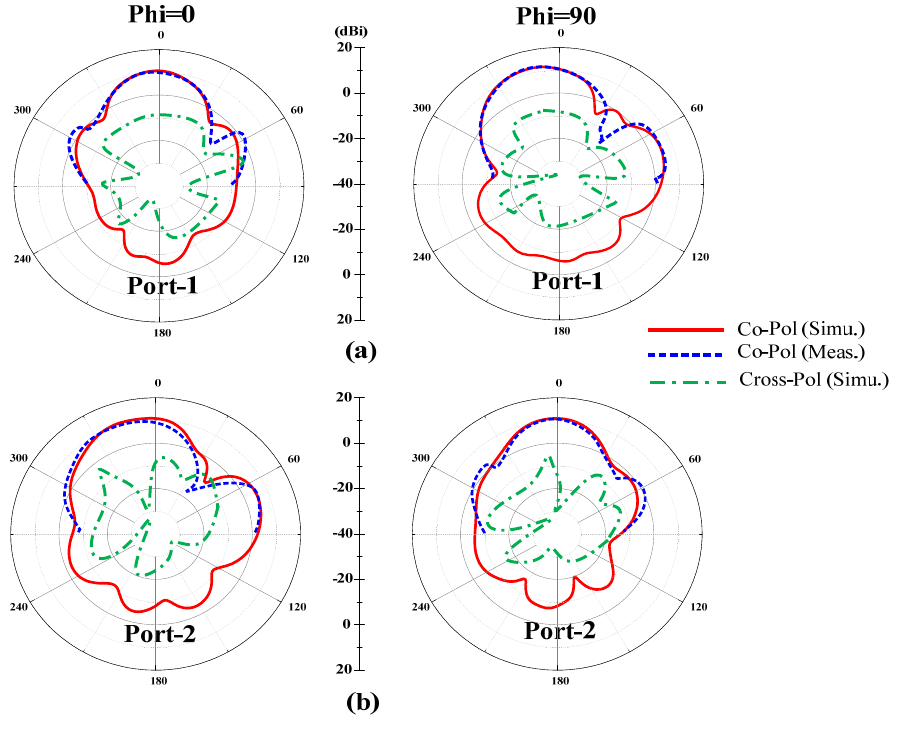
Figure 11. Radiation Patterns at 28 GHz. ( a ) Ant1; ( b ) Ant2.